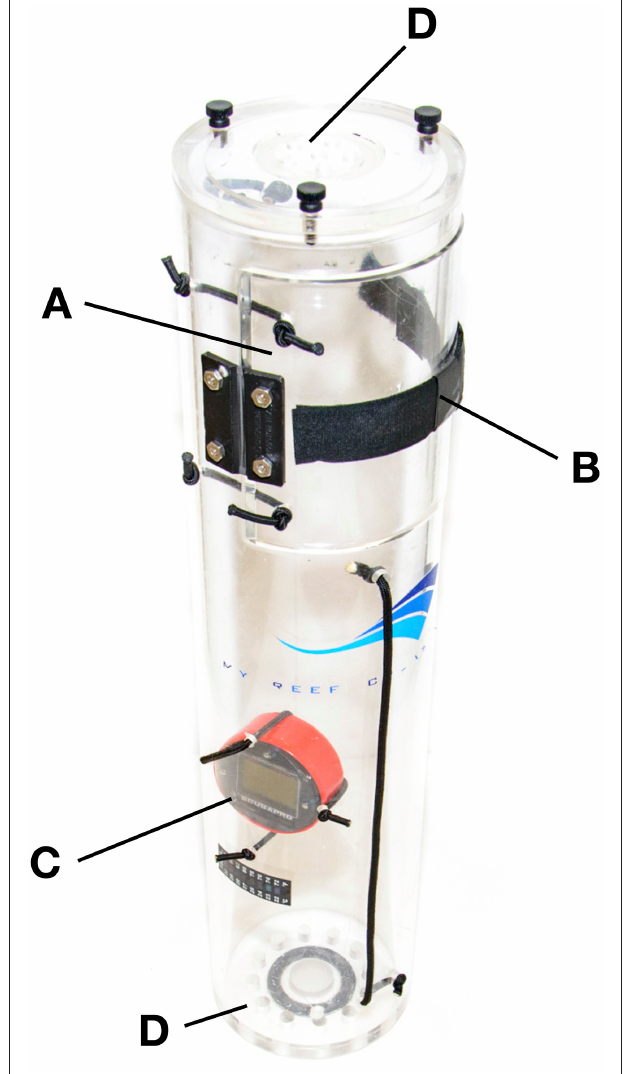
FIGURE 3 | The custom-designed inner collecting jar, showing: (A) the hinged access door that divers use when collecting fishes, (B) the Velcro “lock” for the access door, (C) the submersible depth gauge and (D) the small holes for channeling water flow through the jar during